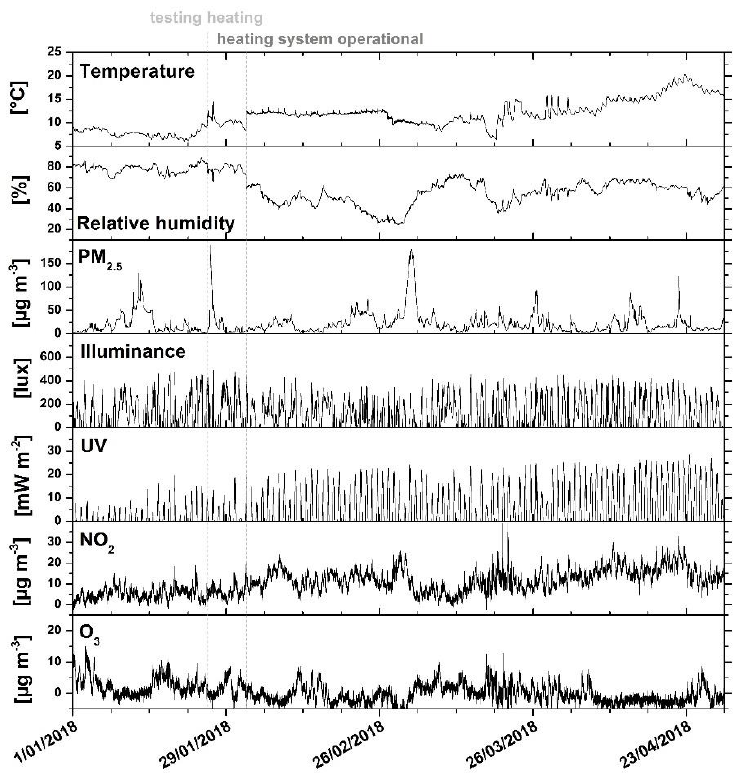
Figure 5. Scatter plot of the measured markers in the period, 1 January 2018 to 30 April 2018. The vertical dashed lines indicate the test period of the heating system and the moment at which the heating system became operational.